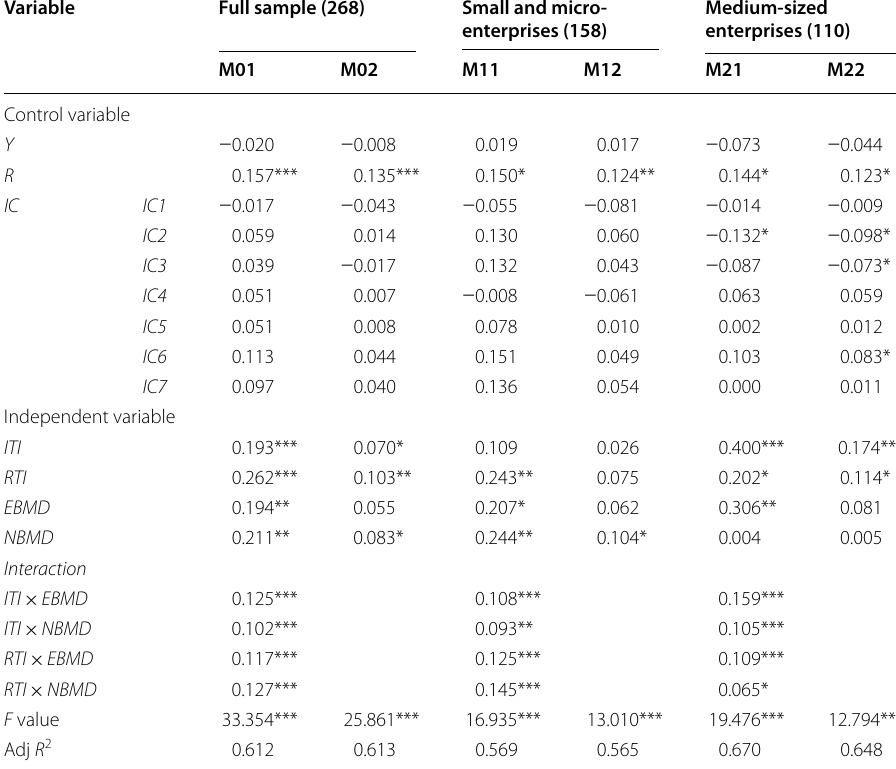
The dependent variable is the business performance of SMEs and all coefficients are normalized coefficients. Significant levels: 0.001 (***), 0.01 (**), 0.05